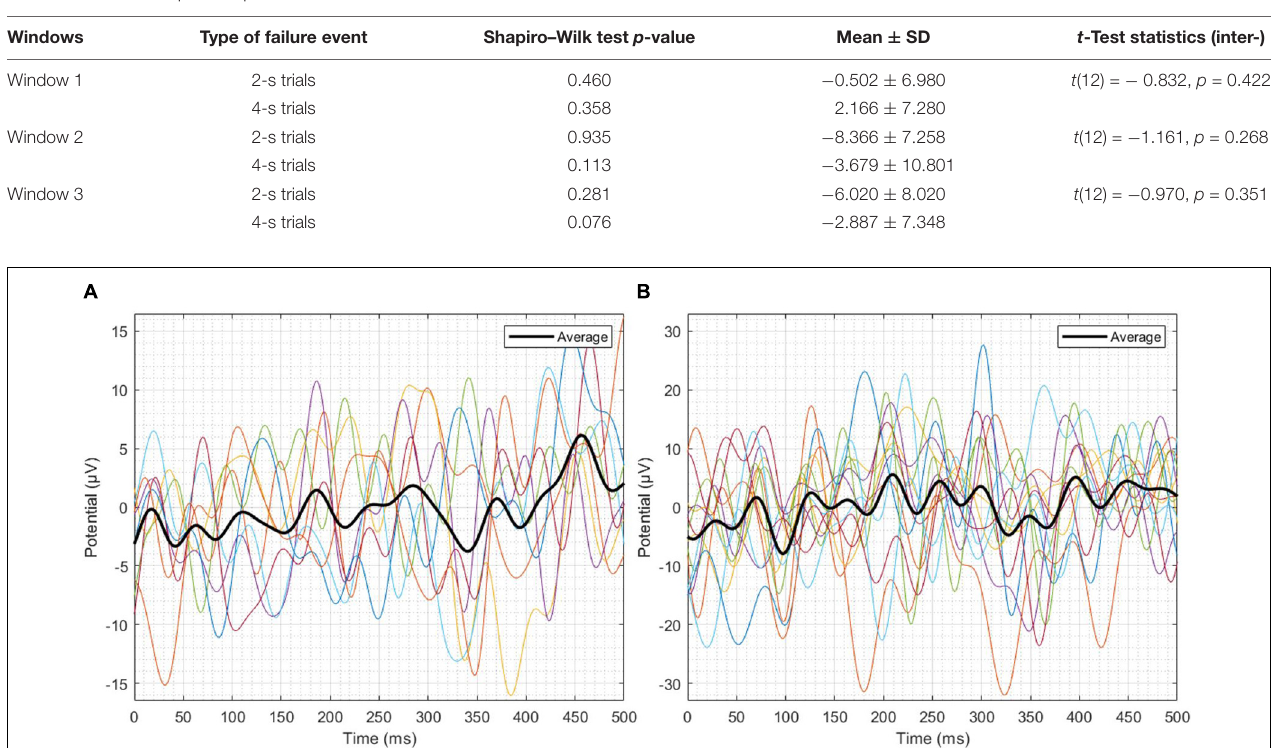
comparison of 2- and 4-s failure trials taken collectively with the success trials can be